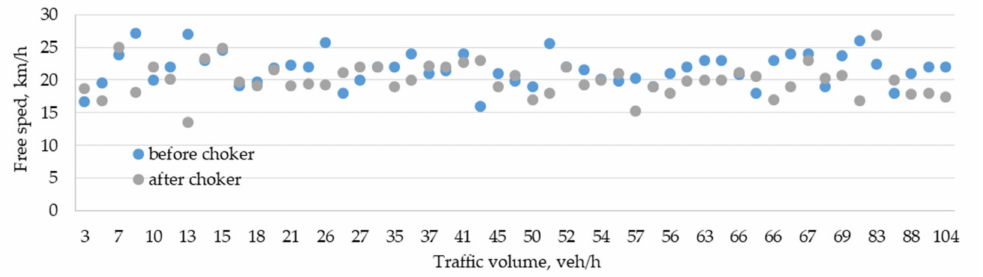
Figure 14. Summary of 85th percentile free-flow speed changes depending on hourly traffic (testing ground No. 1). Source: own work of the author.